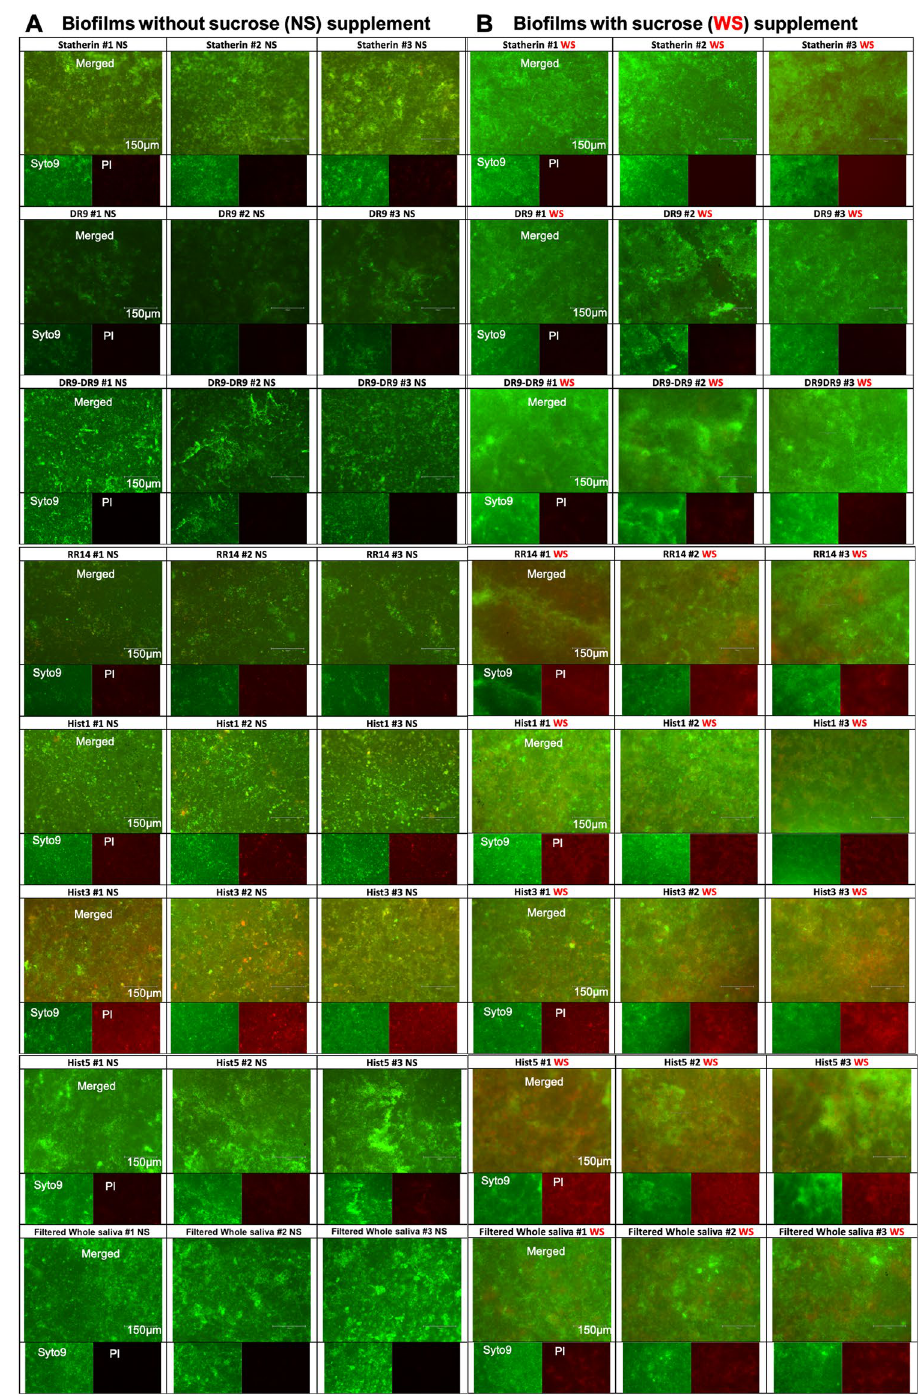
Figure 3. Live/Dead assay to assess the vitality of biofilms grown on hydroxyapatite (HA) discs pellicle- coated with native protein/peptide candidates under normal and cariogenic conditions: Inverted fluorescent microscope characterization of 24 h S. mutans U159 biofilms stained with Syto-9 “live/green” and Propidium- iodide “dead/red” stains. All biofilms were grown on HA discs pellicle-coated with native, except (DR9-DR9), protein/peptide candidates listed in Table 1. Filtered pooled whole saliva was used as a control. ( A ) “NS” stands for “No Sucrose” where biofilms were grown in BHI medium without sucrose supplementation. ( B ) “WS” stands for “With Sucrose” where biofilms were grown in BHI medium with 1% sucrose supplementation. Sucrose supplementation was included to assess the impact of disaccharides on the behavior of protein/peptide candidates. On each cluster, merged images are on the top and separated live channels are in the (bottom left) and dead channels are in the (bottom right). Scale bar is 150 μm. Hist1, Histatin1; Hist3, Histatin3; Hist5,